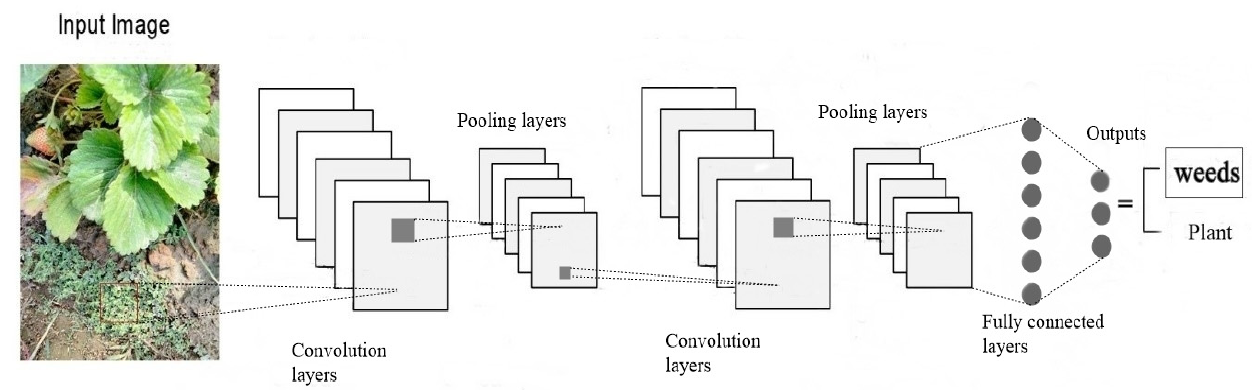
Figure 3. Diagram of a general convolutional neural network algorithm for weed classification. VGG-16, AlexNet, and GoogleNet DCNN models were used to train the weeds and plant classification datasets using the Tensor Flow framework. After training, DCNN models are ready to classify the weeds with real-time input images from the camera (Figure 4). Precision, recall, F1-Score, and overall accuracy were used to assess the perfor- mance of the convolutional neural network models used in this study. Performance re- positive (Tp), false positive (Fp), true negative (Tn), and false negative (Fn) [56]. In this